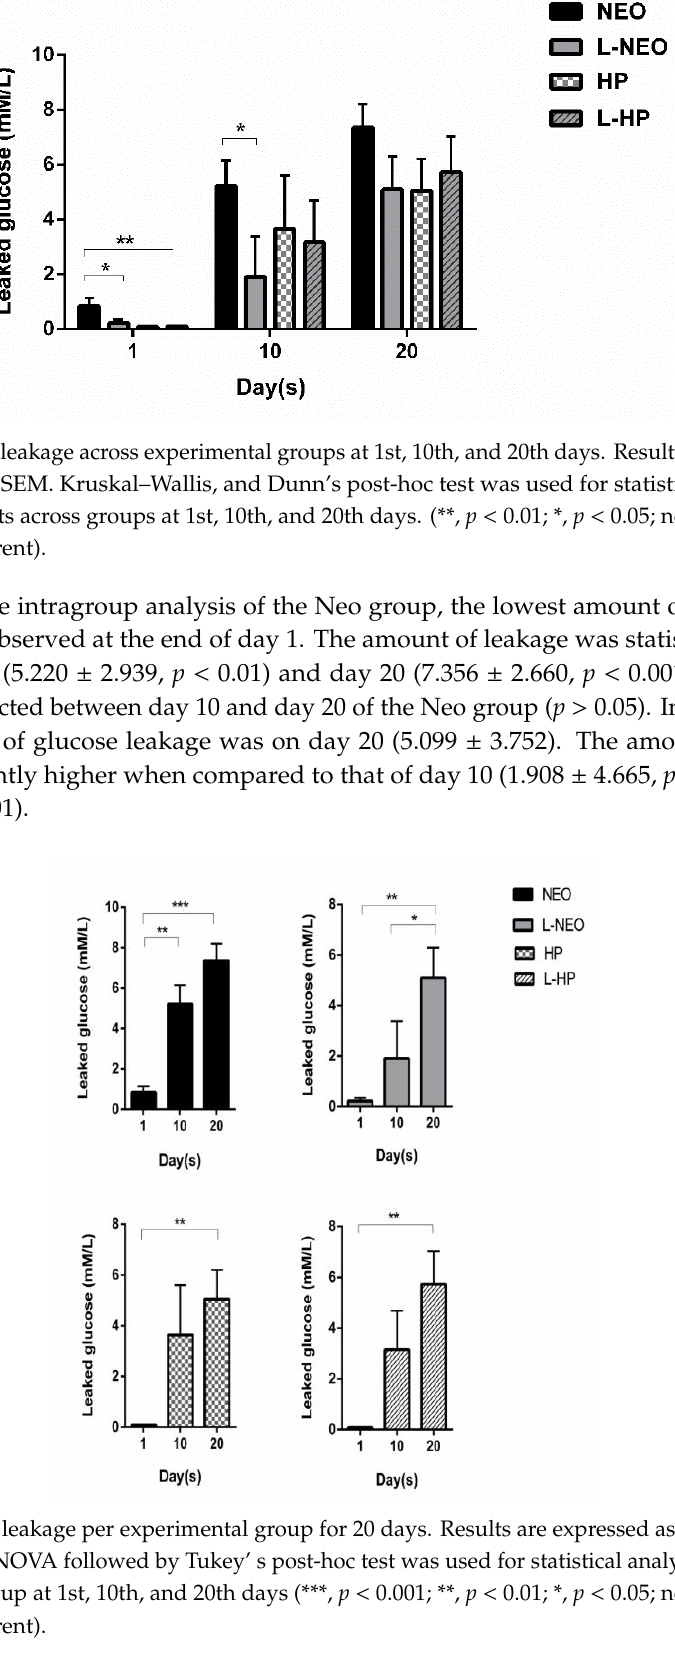
Figure 6. Glucose leakage across experimental groups at 1st, 10th, and 20th days. Results are expressed as mean values + SEM. Kruskal–Wallis, and Dunn’s post-hoc test was used for statistical analysis to compare the results across groups at 1st, 10th, and 20th days. (**, p <0.01; *, p <0.05; no asterisks, not significantly different).